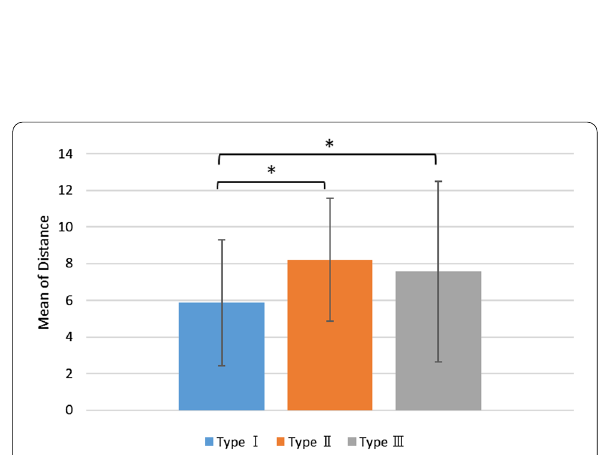
Fig. 17 Means of the score for each type during the attenuation activity (*p <